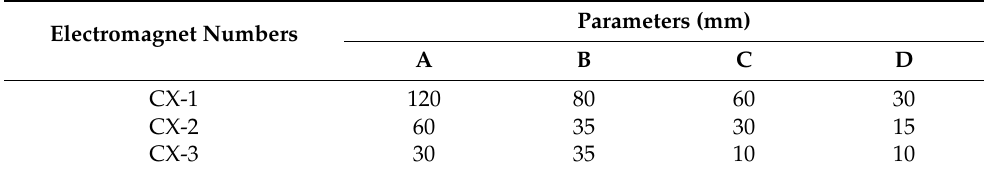
Table 1. Size parameters of the U-shaped cores.